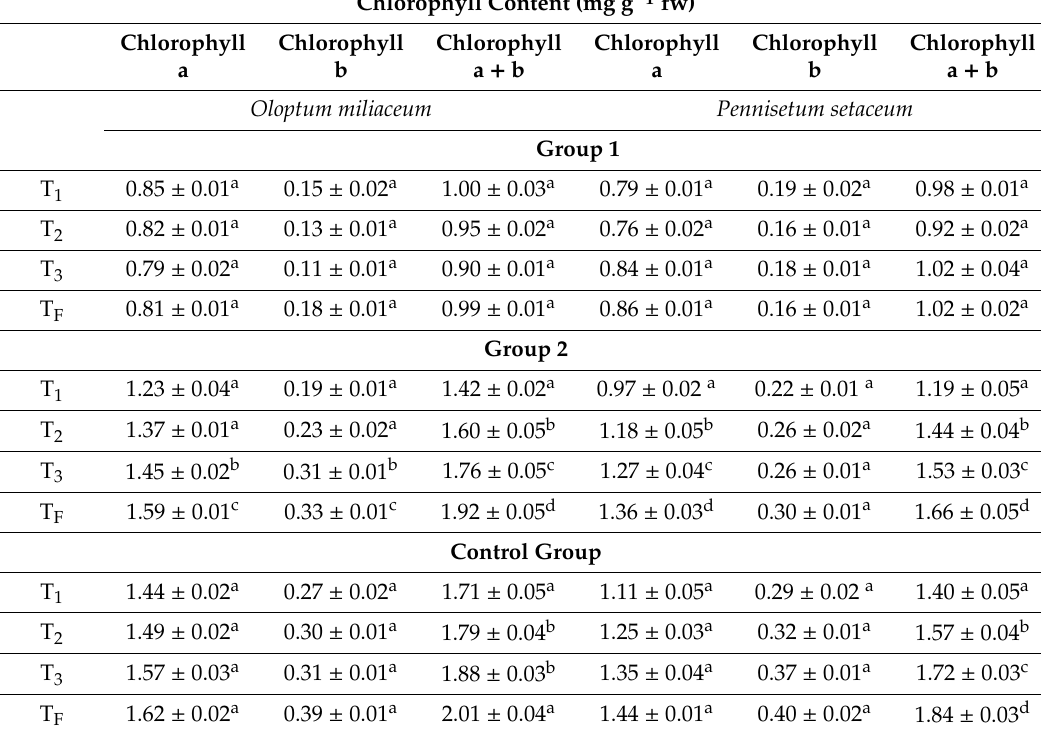
Table 3. Chlorophyll content (mg g − 1 fw) in leaves of Oloptum miliaceum and Pennisetum setaceum for Group 1, 2, and Control Group after 30 (T 1 ), 60 (T 2 ), 90 (T 3 ), and 240 (T F ) days. Values represent mean ± SE. Di ff erent letters indicate means that are significantly di ff erent from each other (Duncan’s test, p <